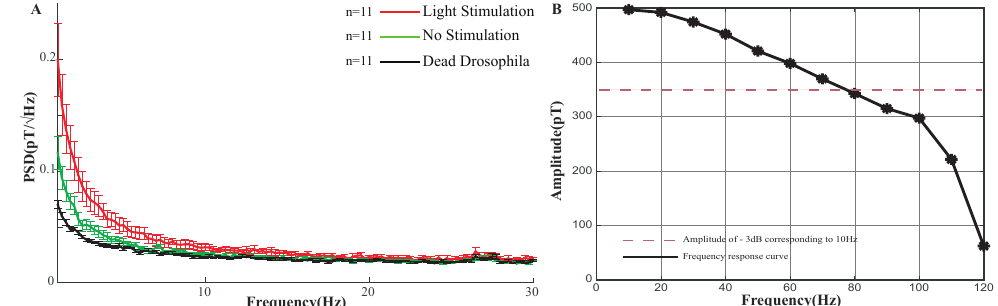
Figure 2. ( A ) Response to continuous light stimulation. Power spectral density (PSD) between 1 and 30 Hz in dead flies (black line) and live flies in the unstimulated state (green line), and in live flies under light stimulation (red line). Each line represents the mean and standard deviation calculated from measurements of multiple flies. Number of measurements per condition: N = 11 (dead flies, black line), N = 11 (live flies without stimulation, green line), N = 11 (live flies with light stimulation, red line). ( B ) Frequency response curve with the amplitude beginning at 500